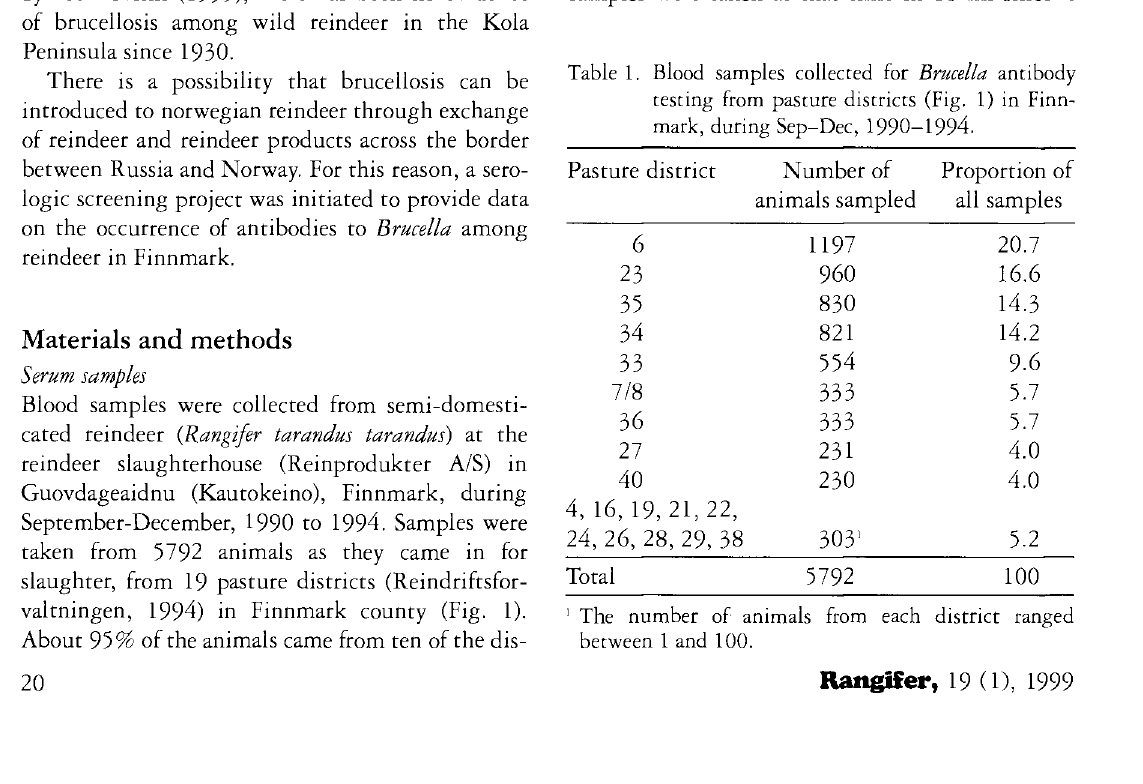
Table 1. Blood samples collected for Brucella antibody testing from pasture districts (Fig. 1) in Finn- mark, during Sep-Dec,